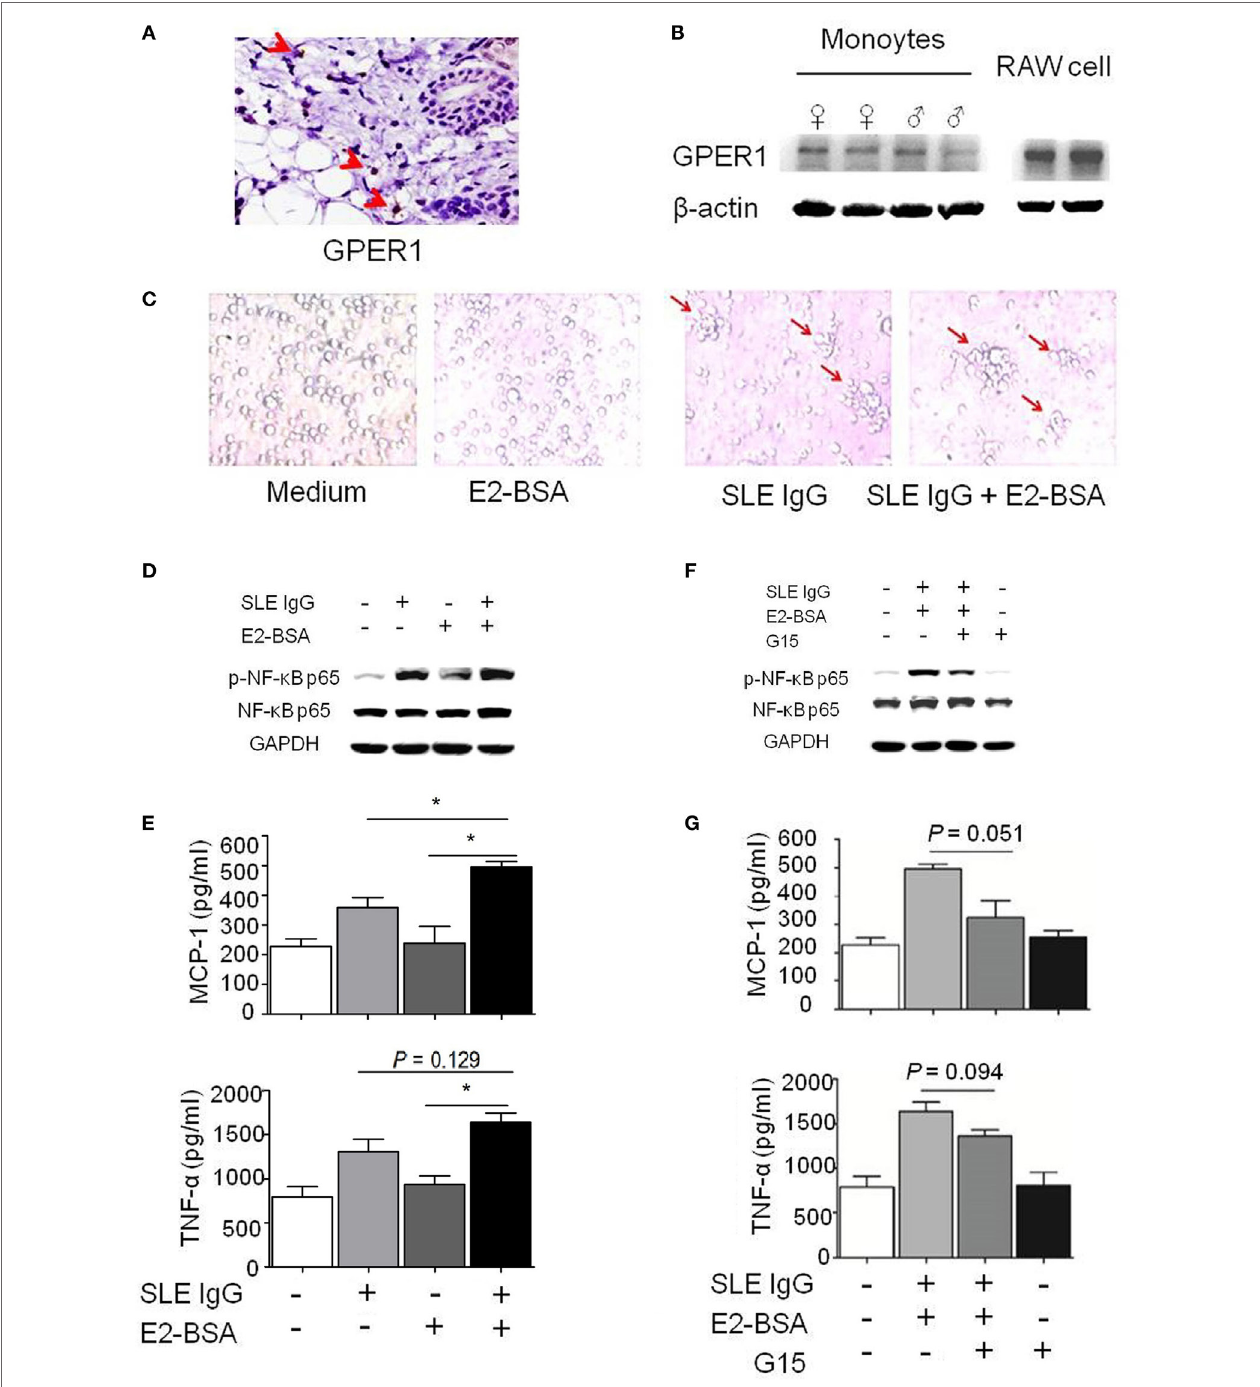
FigUre 3 | E2 promotes activation of systemic lupus erythematosus (SLE) IgG-induced monocytes via the membrane receptor G protein-coupled estrogen receptor 1 (GPER1). (a) Immunohistochemical staining for GPER1 expression in skin lesions of C57BL/6 mice 3 days after intradermal inoculation of SLE serum. The arrows represent GPER1 + cells. (B) Western blot-measured GPER1 expression in Raw264.7 cells and monocytes from C57BL/6 mice. (c) Representative photographs of monocytes cultured with medium control, E2-BSA, SLE IgG, or SLE IgG + E2-BSA for 48 h. Monocytes were isolated from spleen of C57BL/6 mice. Original magnification 20 × and the arrows represent typical differentiation of monocytes into dendritic cells. (D) Western blot-measured levels of p-NF- κ B p65/ NF- κ B p65 in Raw264.7 cells treated with medium control, SLE IgG, E2-BSA, or SLE IgG + E2-BSA for 30 min. (e) CBA-measured levels MCP-1 or TNF- α in supernatants of Raw264.7 cells treated with medium control, SLE IgG, E2-BSA, or SLE IgG + E2-BSA for 24 h. * P < 0.05. (F) Western blot-measured levels of p-NF- κ B p65/NF- κ B p65 in Raw264.7 cells treated with medium control, SLE IgG + E2-BSA, SLE IgG + E2-BSA + G15, or G15 for 30 min. (g) CBA-measured levels of MCP-1 or TNF- α in supernatants of Raw264.7 cells treated with medium control, SLE IgG + E2-BSA, SLE IgG + E2-BSA + G15, or G15 for 24